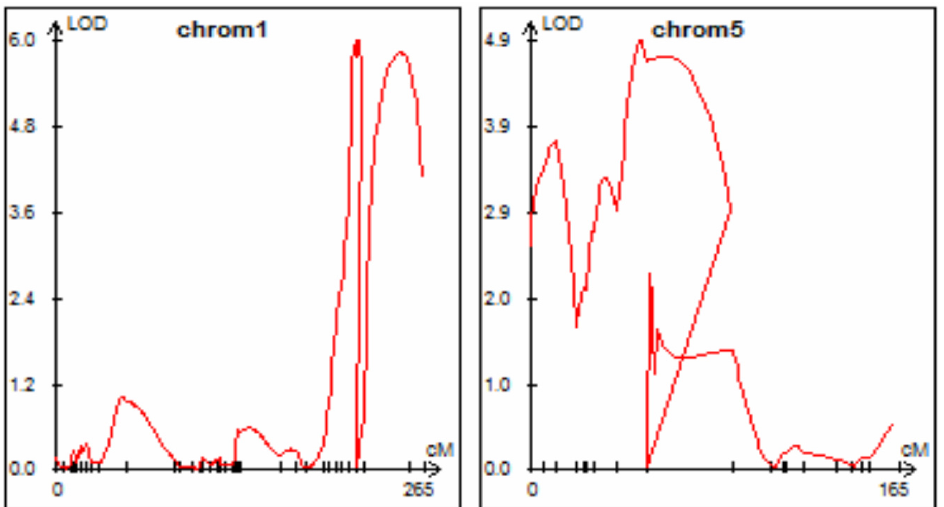
Fig 1. Six QTLs and one epistasis detected by MIM for grain yield on rice chromosome 1 and 5 under E1